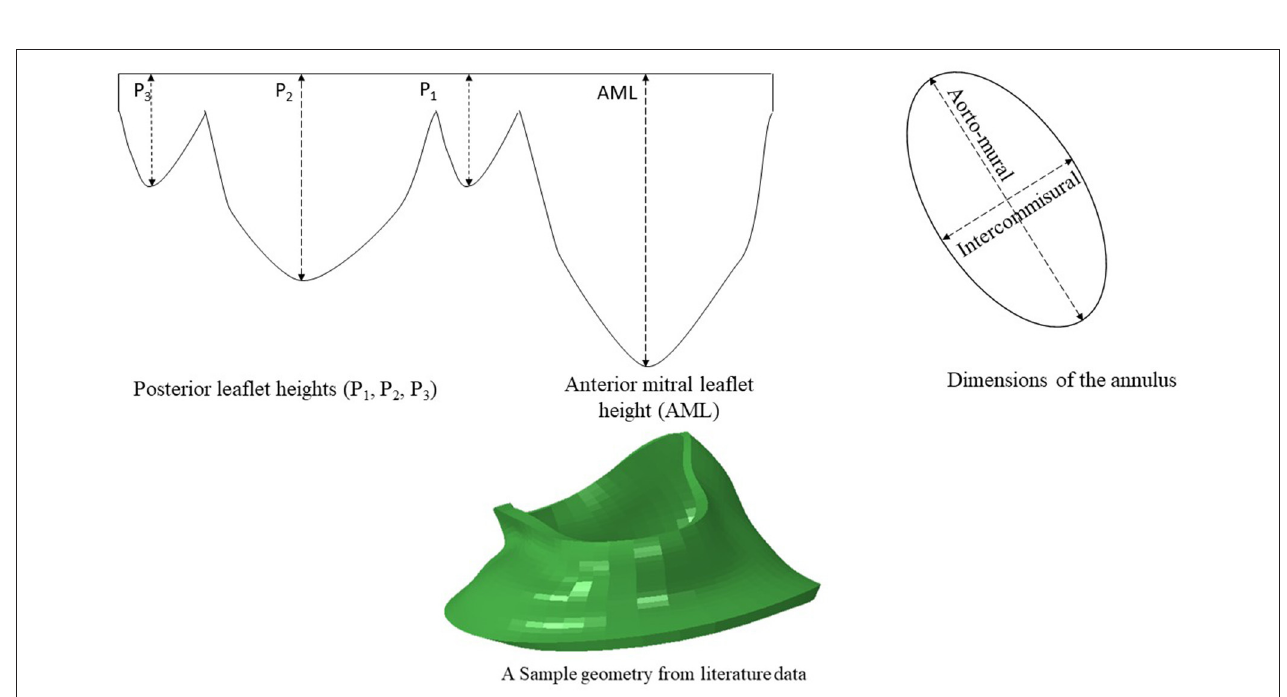
FIGURE 2 | The dimensions of six key points were computed from literature. The diameters of the annulus (two dimensions) and the leaflet edge dimensions (four points) were adopted from data in the literature (15). A sample geometry created from literature data is